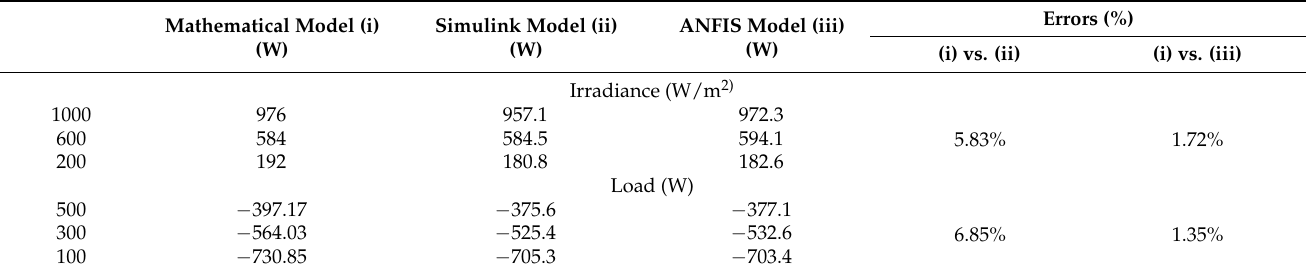
Table 5. Power comparison between mathematical model, simulation model, and ANFIS model.